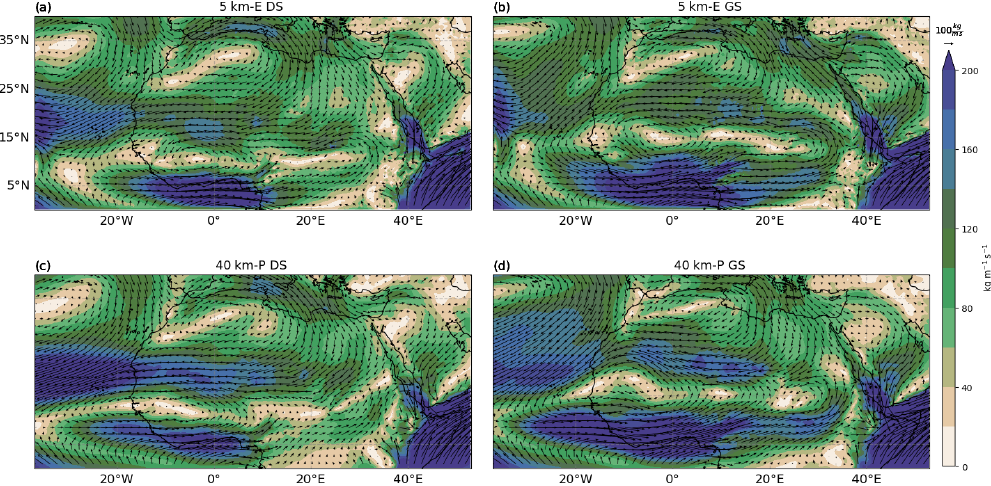
Figure A3. JAS mean 1000 to 200hPa vertically integrated moisture flux magnitude (shading) and vertically integrated moisture flux vectors (kgm − 1 s − 1 ) for the 5km-E DS (a) and GS (b) , as well as for the 40km-P DS (c) and GS (d) simulation.